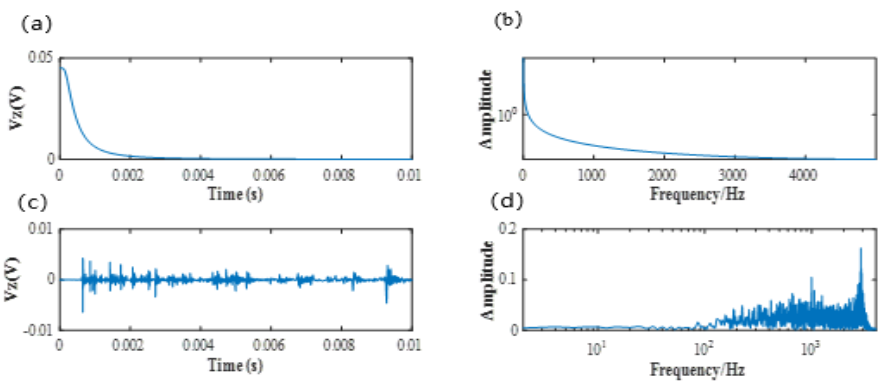
Figure 7. The separated signals after SSA. ( a ) GREATEM signal; ( b ) frequency spectrum of GREATEM signal; ( c ) noise; ( d ) frequency spectrum of noise.